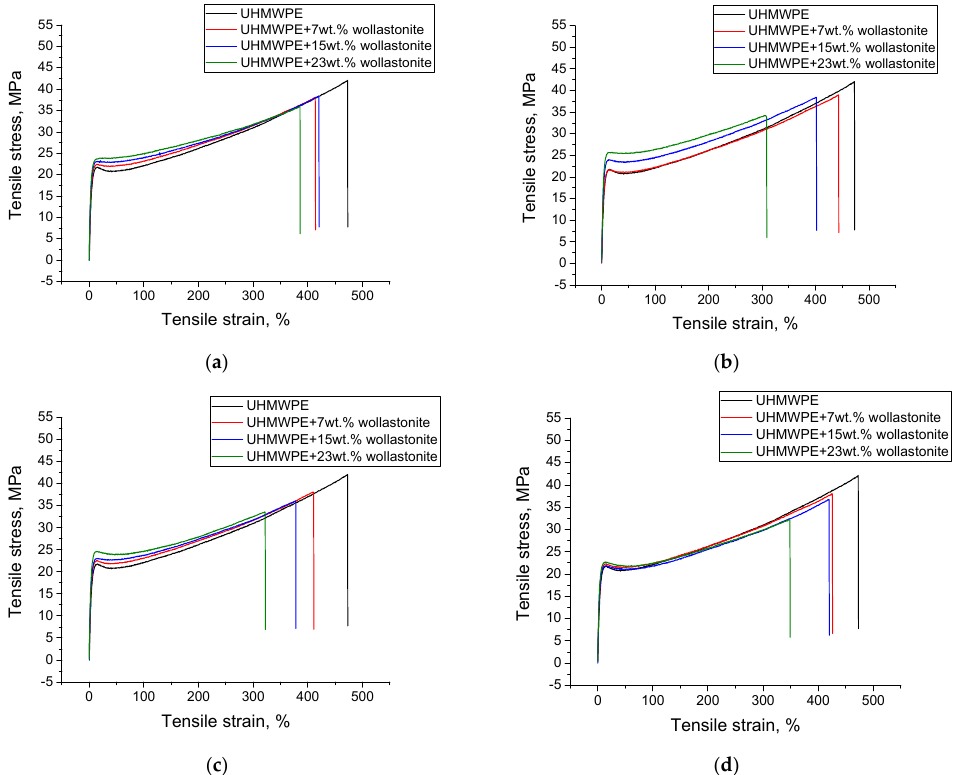
Figure 2. Engineering stress–strain curves of neat ultrahigh molecular weight polyethylene (UHMWPE) and the UHMWPE-based composites: ( a ) untreated; ( b ) “KH-550”; ( c ) “Penta-1006”; and ( d ) “OTS”. Table 1. The physico-mechanical properties of neat ultrahigh molecular weight polyethylene (UHMWPE) and the UHMWPE-based composites; untreated. Filler Composition,wt.%